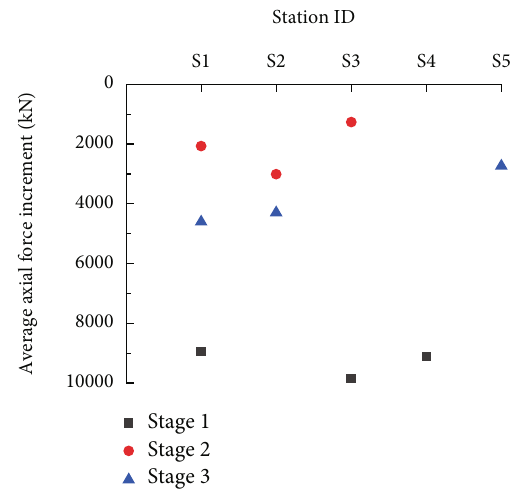
Figure 10: Axial force increment in three construction stages of strip foundation stations.